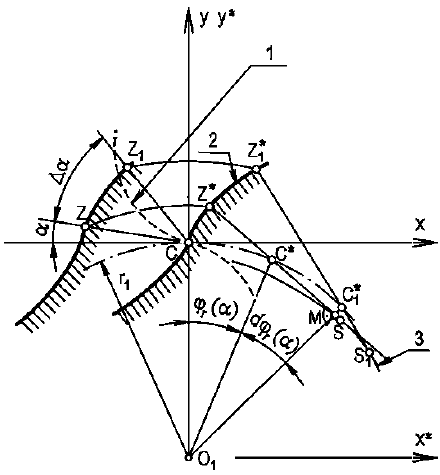
Figure 2. Relation between the angles α and ϕr : 1—path of contact, 2—tooth flank profile, and 3—tooth flank profile evolute.